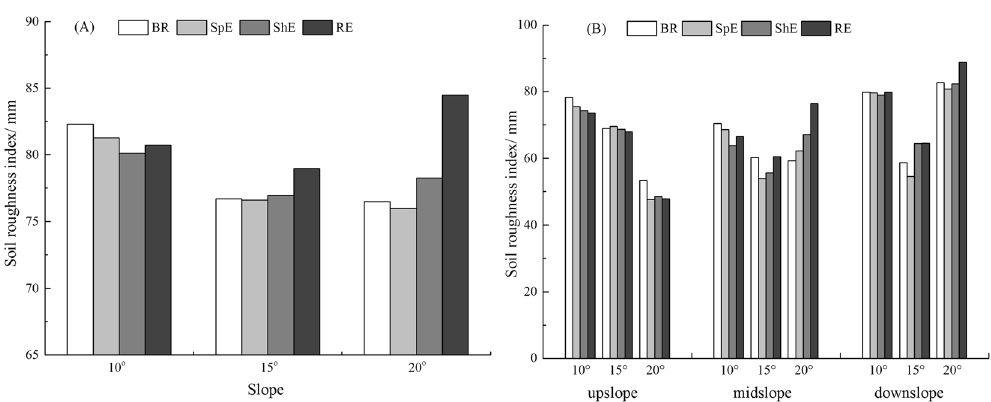
Figure 2. Change characteristics of soil roughness in entire slope ( A ) and different position ( B ) at different erosive